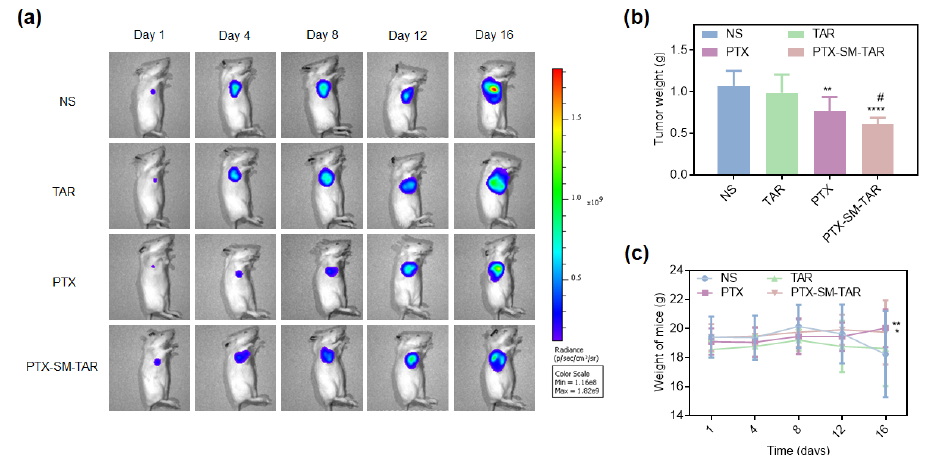
Figure 9. In vivo antitumor efficacy of PTX-SM-TAR NPs on 4T1-mCherry-Luc xenograft mice model ( n = 7). ( a ) In vivo bioluminescence images of 4T1-mCherry-Luc tumor-bearing mice on 1, 4, 8, 12, and 16 d. ( b ) Weight of the excised tumors (mean ± SEM, n = 7, ** and **** represent p < 0.01 and p < 0.0001 versus the NS group, # represents p < 0.01 versus the PTX group). ( c ) Changes in mice’s body weight during the treatment process. * and ** represent p < 0.05 and p < 0.01. In addition, the TUNEL and H&E staining results of tumor tissues showed that the TNBC treated with PTX and PTX-SM-TAR NPs had obvious apoptosis and serious tissue